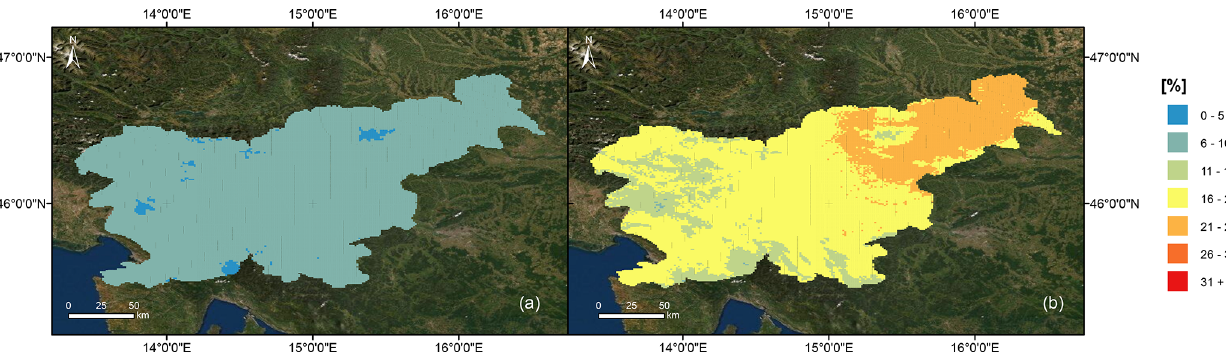
Figure 9. Uncertainty of (a) SDII – daily precipitation intensity and (b) CDD – maximum number of consecutive dry days (Esri, 2020; GISCO,